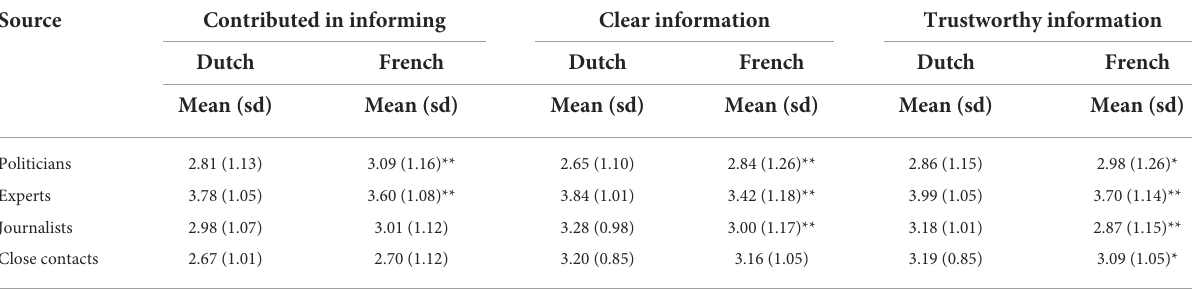
TABLE 1 Respondents’ perception of different information sources on COVID-19 measures.